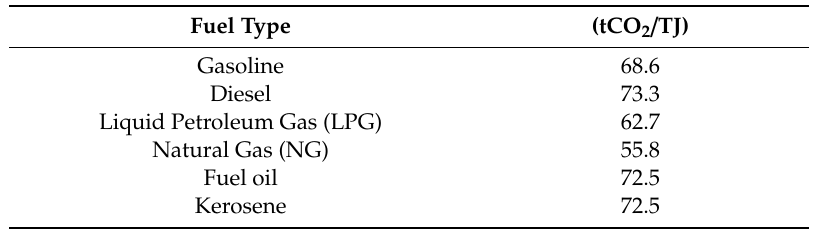
Table 6. Emission factors by fuel